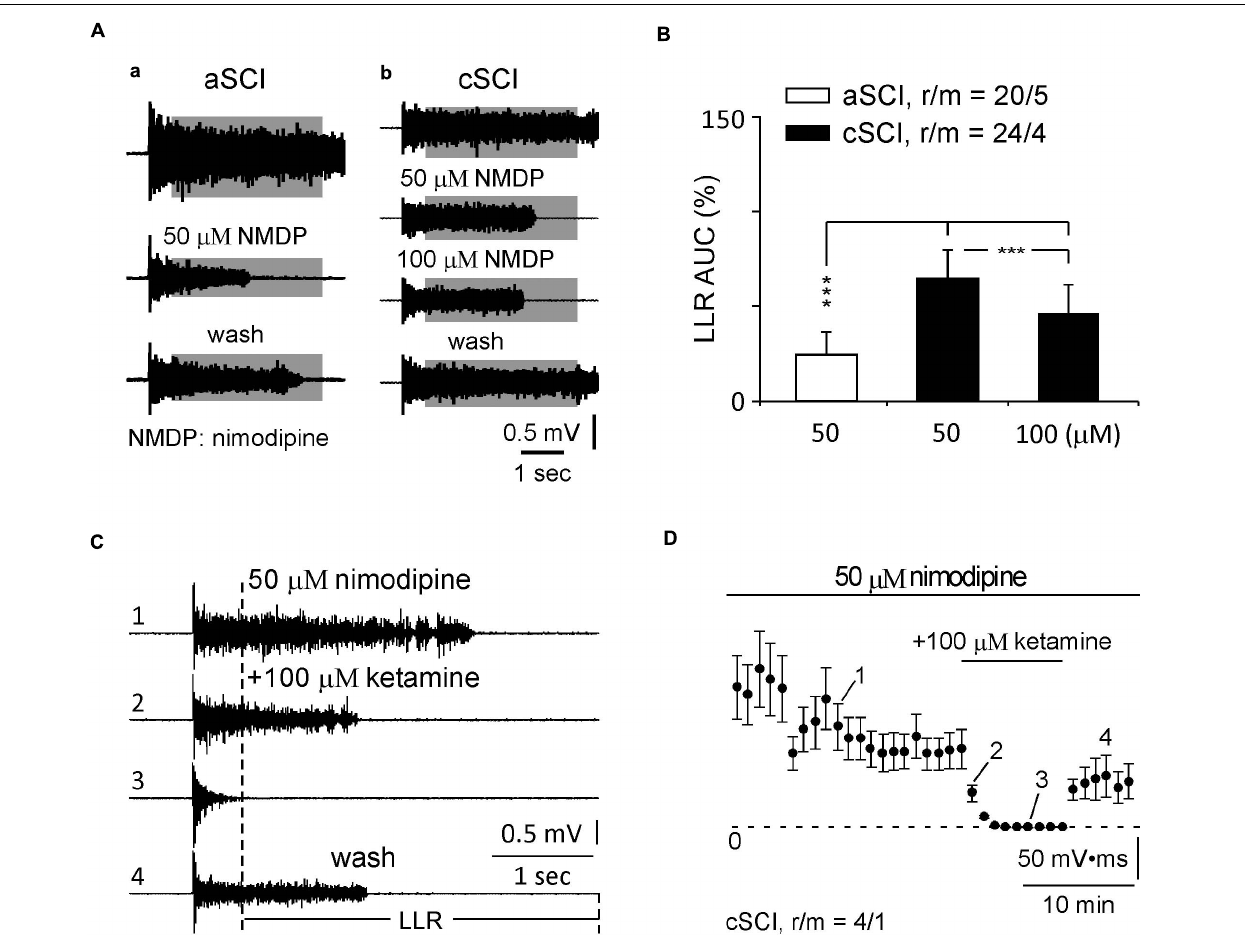
FIGURE 3 | Inhibition of nimodipine and ketamine on LLRs. (A) Sample recordings show the responses of LLRs to nimodipine at 50 and 100 µ M in an aSCI and a cSCI mouse. (B) Histogram shows the statistics of nimodipine’s effects on LLRs. r/m, roots/mice. (C) Sample recordings of LLRs in nimodipine and ketamine. Numbers (1–4) indicate the recordings before, in and after ketamine treatment. (D) Time course of LLRs in nimodipine and ketamine. The plot displays the averaged AUC values of LLRs with numbers (1–4) matching numbers (1–4) in (C) . The asterisks represent the results of t -tests (*** p < 0.001), and r/m represents